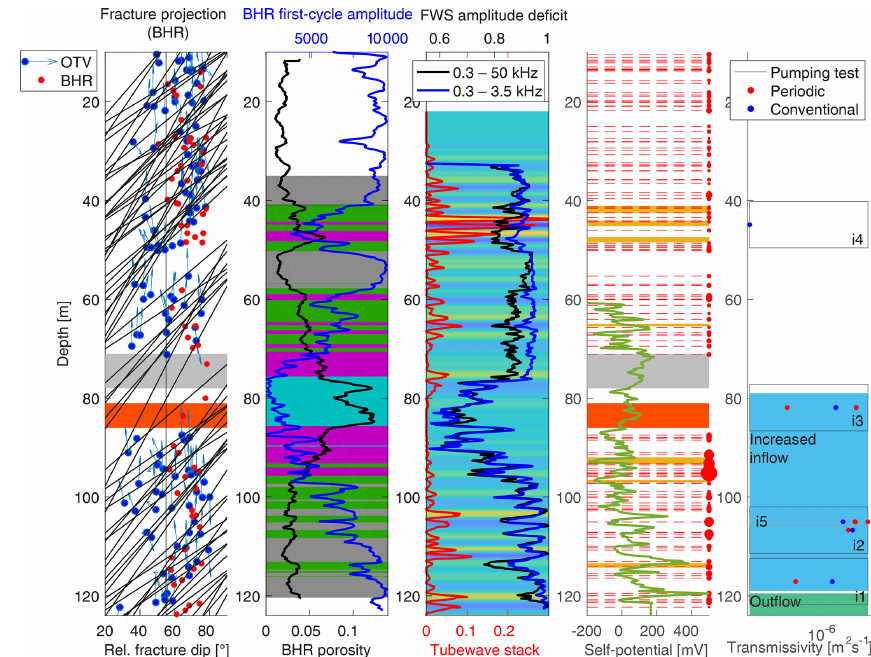
Figure 13. From left to right: projection of imaged BHR reflections onto the borehole track together with associated dip, tadpoles illustrating the azimuth, and dip for the fractures identified from the OTV data; results of cluster analysis overlain by BHR porosity and BHR amplitudes; tube wave stack overlain by tube wave energy (Greenwood et al., 2019) and Stoneley energy deficit; brittle deformation data overlain by the corrected SP log (2017); and summary of transmissivities estimated from pumping tests (Cheng and Renner, 2017). Table 3. Petrophysical properties of the cluster groups (25th and 75th percentile) and core